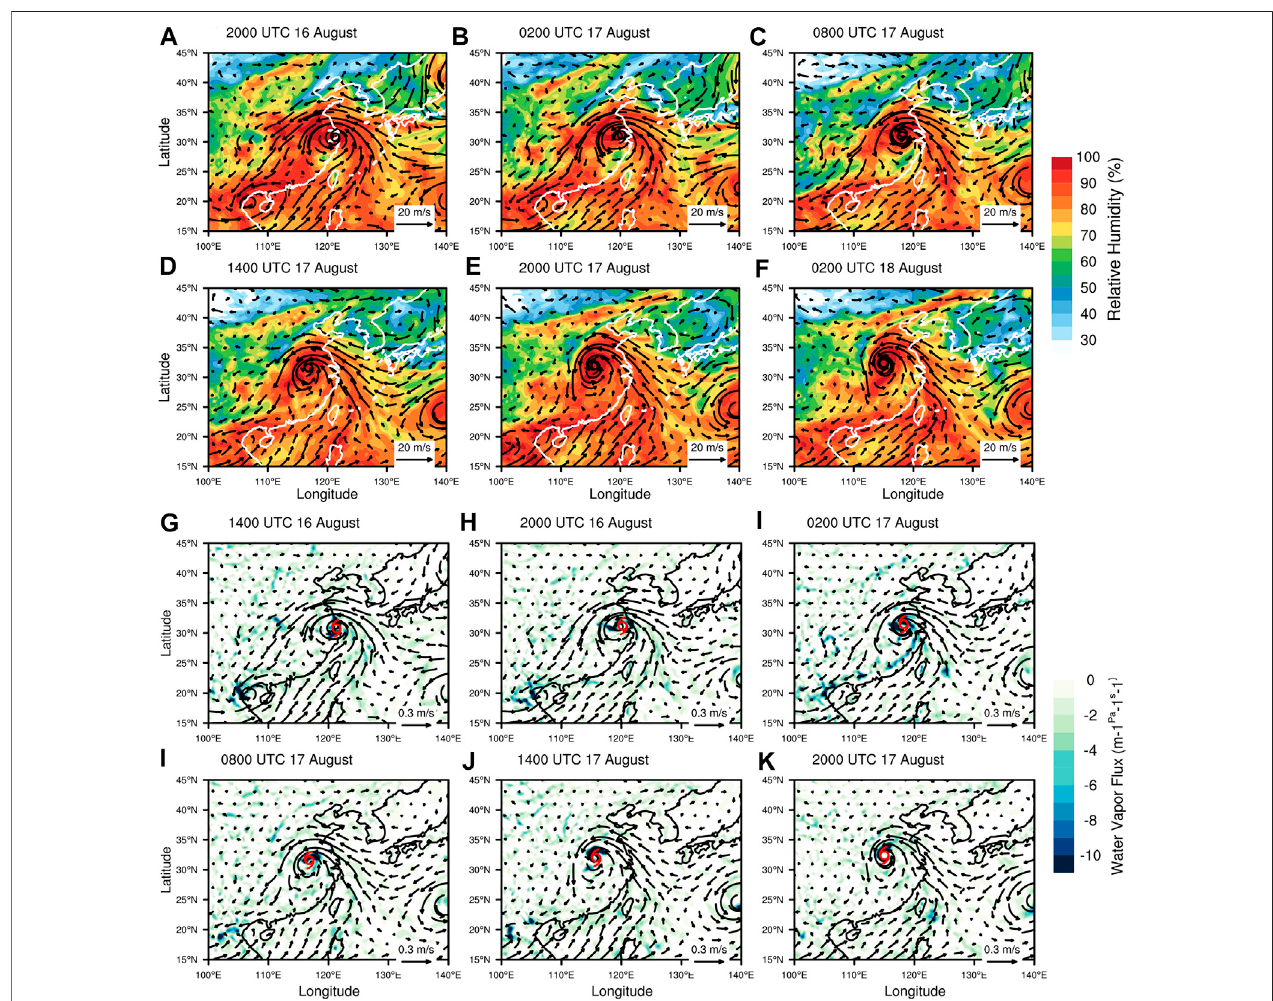
FIGURE 9 | The evolution of the lower tropospheric relative humidity (shading, %) and wind vectors (m s − 1 ), both averaged between 700 and 1,000 hPa: (A) 2000 UTC16August, (B) 0200, (C) 0800, (D) 1,400, (E) 2000UTC17August, (F) 0200UTCAugust18,2018.Thelowertroposphericwatervapor fl ux(arrows,m − 1Pa − 1 s − 1 ) and vapor fl ux divergence (shading, m − 2 Pa − 1 ), both averaged between 700 and 1,000 hPa: (G) 2000 UTC 16 August, (H) 0200, (I) 0800, (J) 1,400, (K) 2000 UTC 17 August, (L) 0200 UTC August 18, 2018. The cyclone symbol indicates the storm center at the given time.